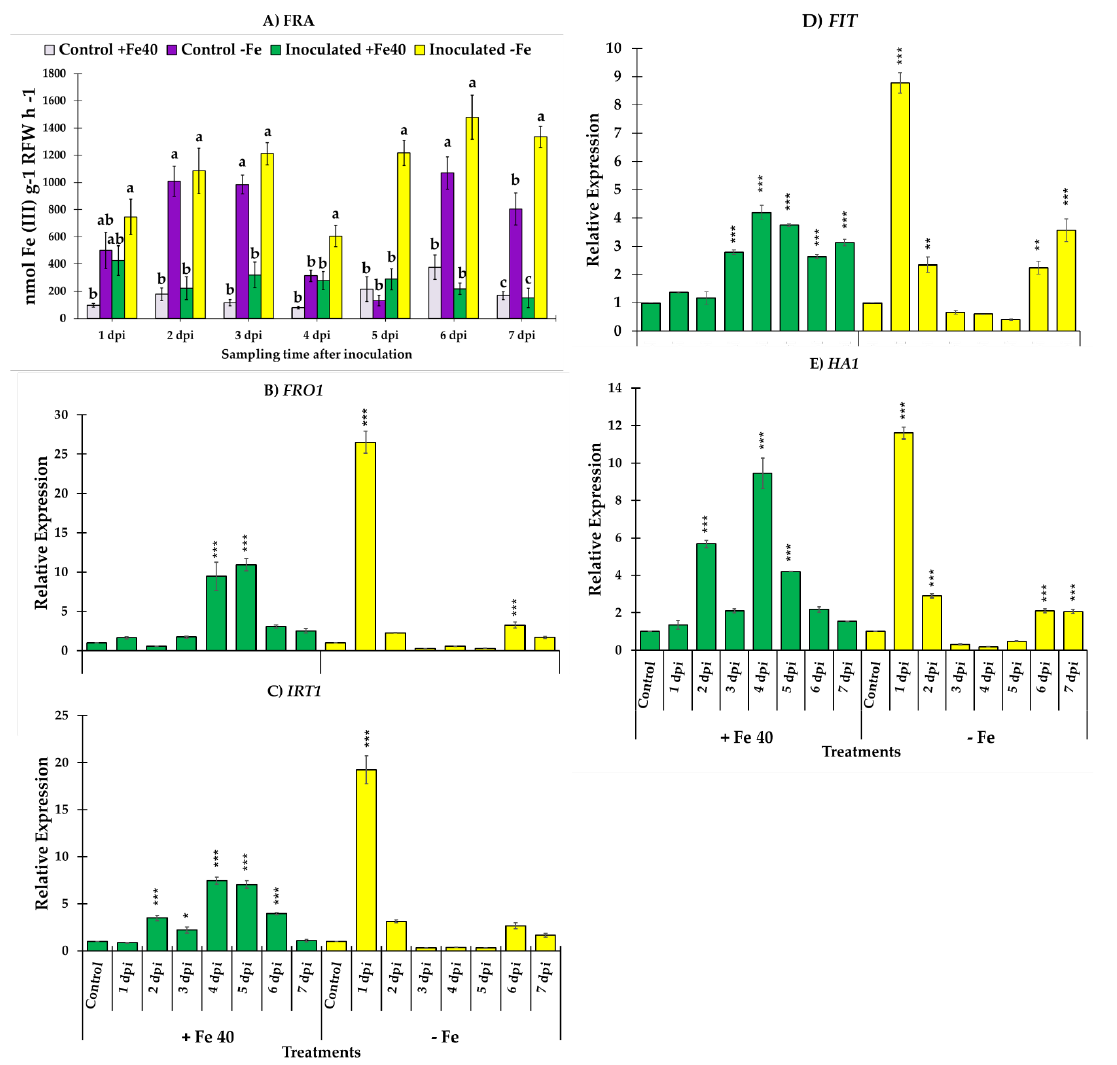
Figure 3. Evolution of FRA along seven days of observation and relative expression of FRO1 , FRO2 , FRO3 , IRT1 and FIT , in C. melo roots. Four treatments were used, namely, (i) Control + Fe40 µ M (un-inoculated), (ii) Inoculated + Fe40 µ M, (iii) Control - Fe (un-inoculated) and (iv) Inoculated - Fe. The expression of control treatment for each nutritional condition is presented once, at the beginning of the graph, with the relative expression comparison method used, the control is always equal to 1. Data of gene expression represent the mean of three independent technical replicates, according to the Dunnett’s test, * ( p < 0.05), ** ( p < 0.01) or *** ( p < 0.001) over the bars indicate significant differences in relation to the control treatment. In the case of FRA, letter over the bars denote significant difference between plants inoculated and control plants analyzed by completely randomized ANOVA followed by a Tukey test ( p <